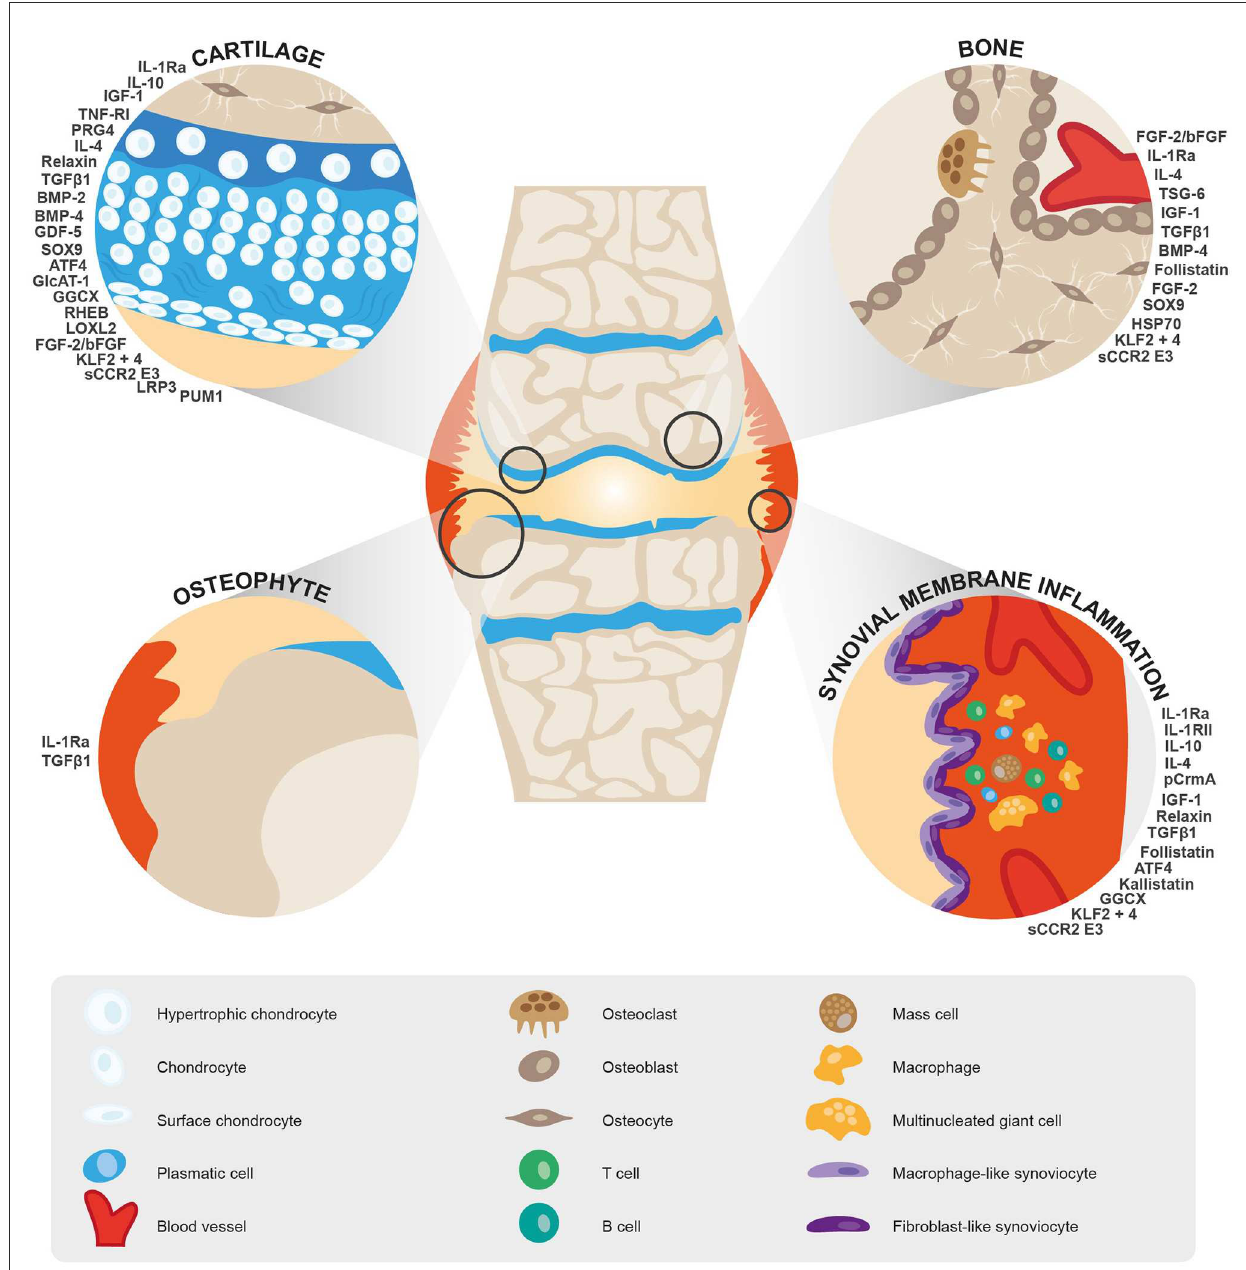
FIGURE3 Schematic representation of targets identified for gene therapy of OA and their therapeutic